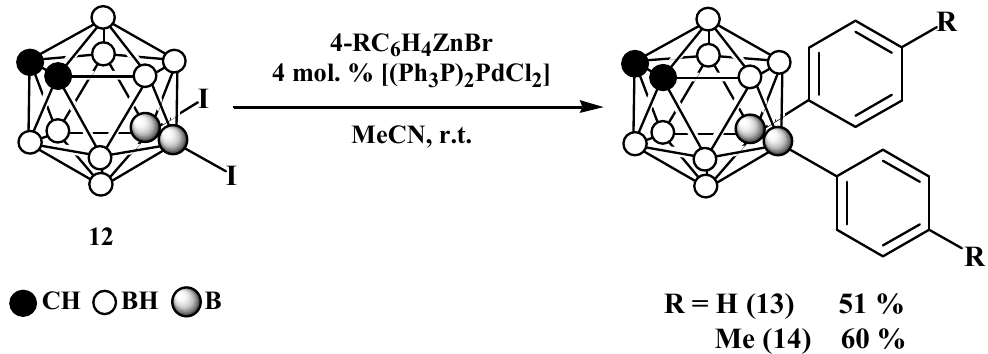
Scheme 4. Synthesis of 9,12-diaryl- ortho